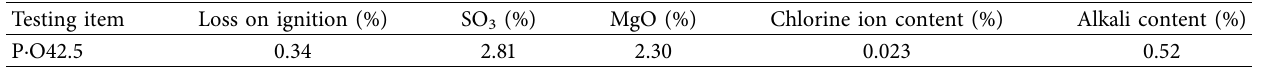
Table 3: Quality testing of P · O42.5 cement.